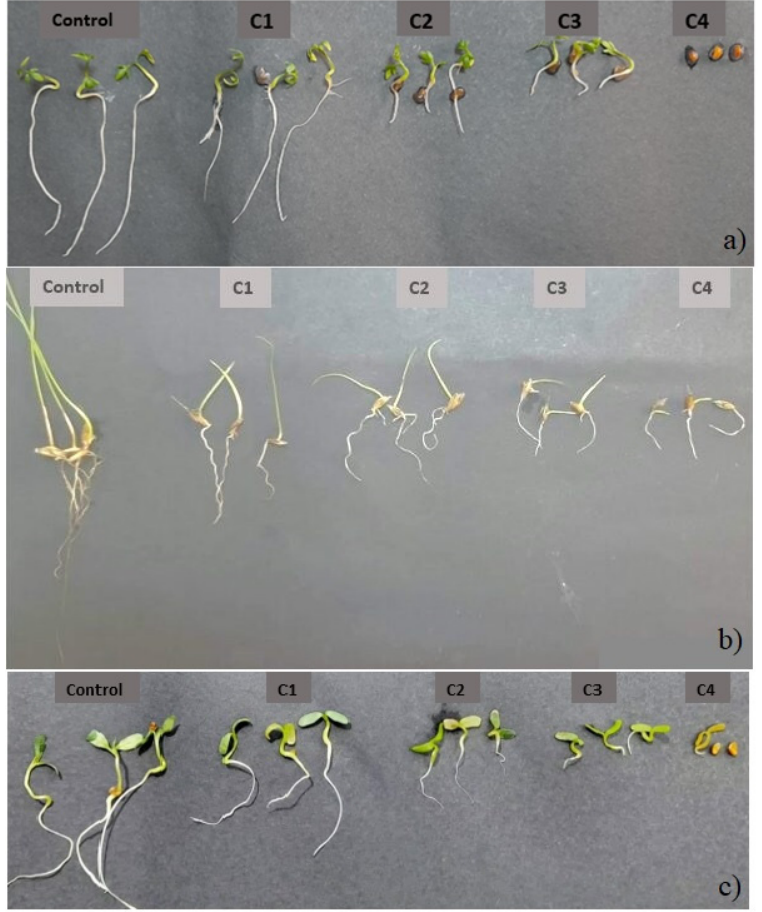
Figure 2. Phytotoxic effects of the studied EOs on S. arvensis ( a ), L. rigidum ( b ) and T. campestre ( c ).